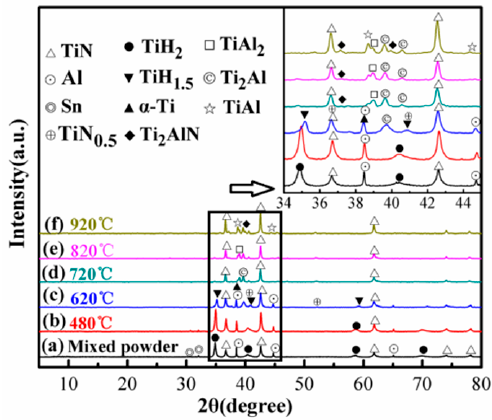
Figure 5. XRD patterns of the 1TiH 2 / 1.15Al / 1TiN powder sample after 1 min of sintering at di ff erent temperatures (480–920 °C): ( a ) Mixed powder; ( b ) 480 °C; ( c ) 620 °C; ( d ) 720 °C; ( e ) 820 °C; ( f ) 920 °C.